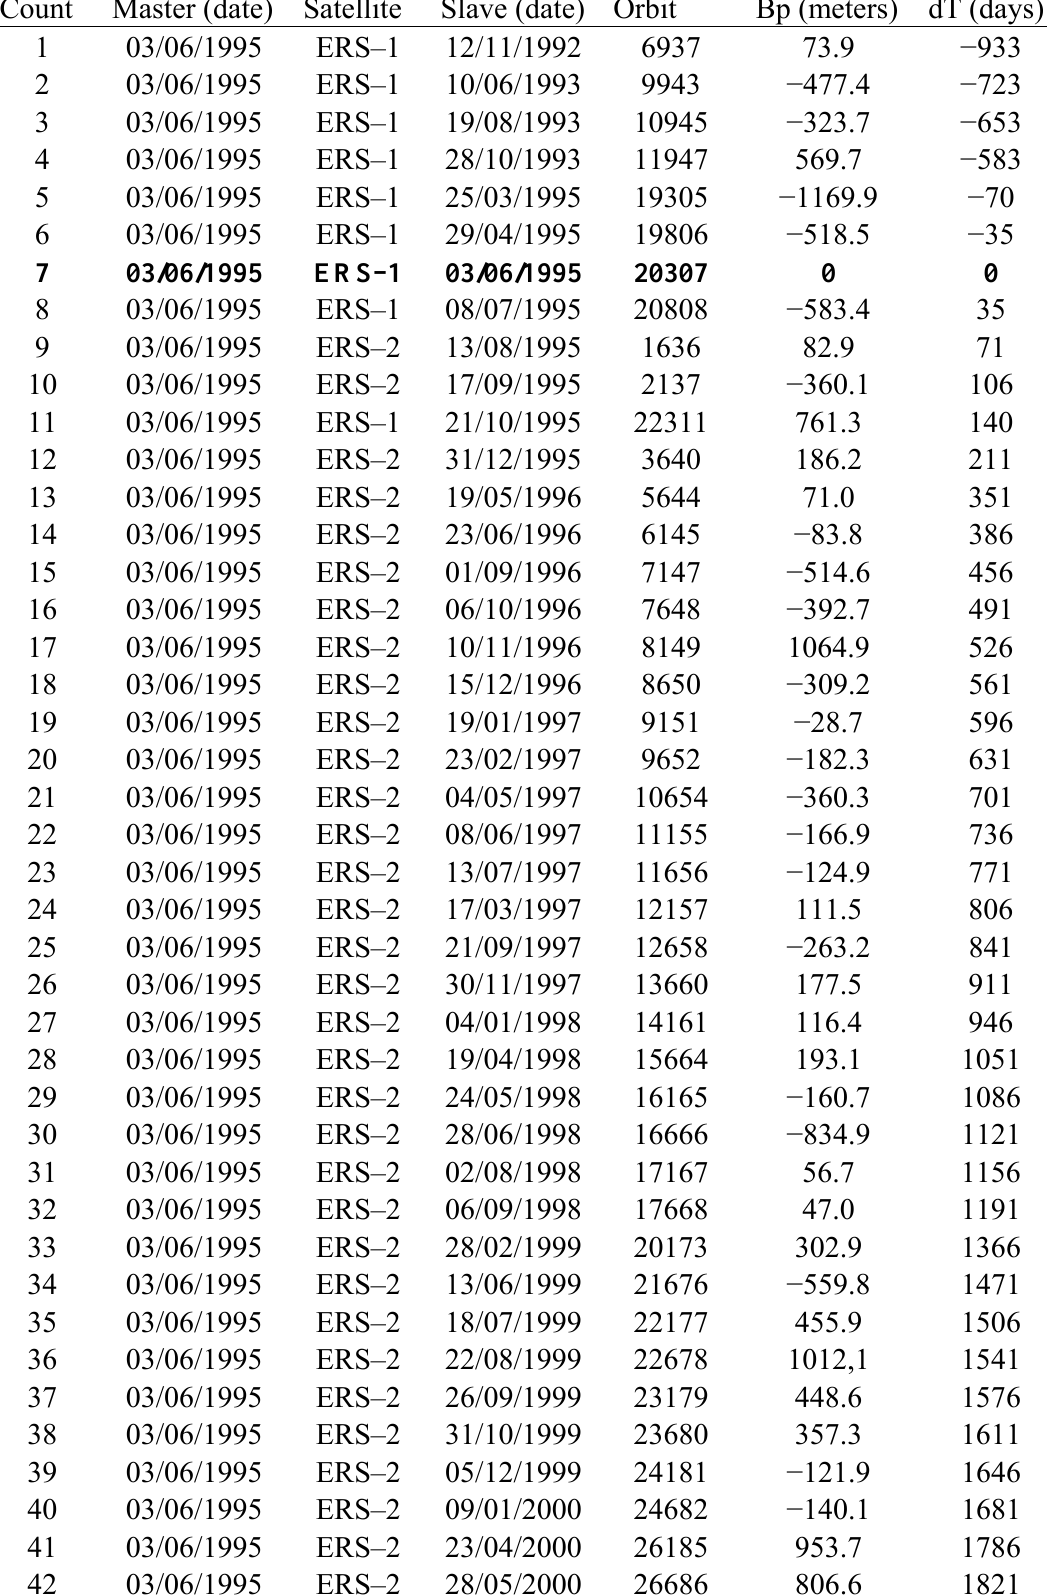
Table 1. ERS–1 & 2 scenes (Track = 279, Frame = 2835) that have been used (in bold the master reference